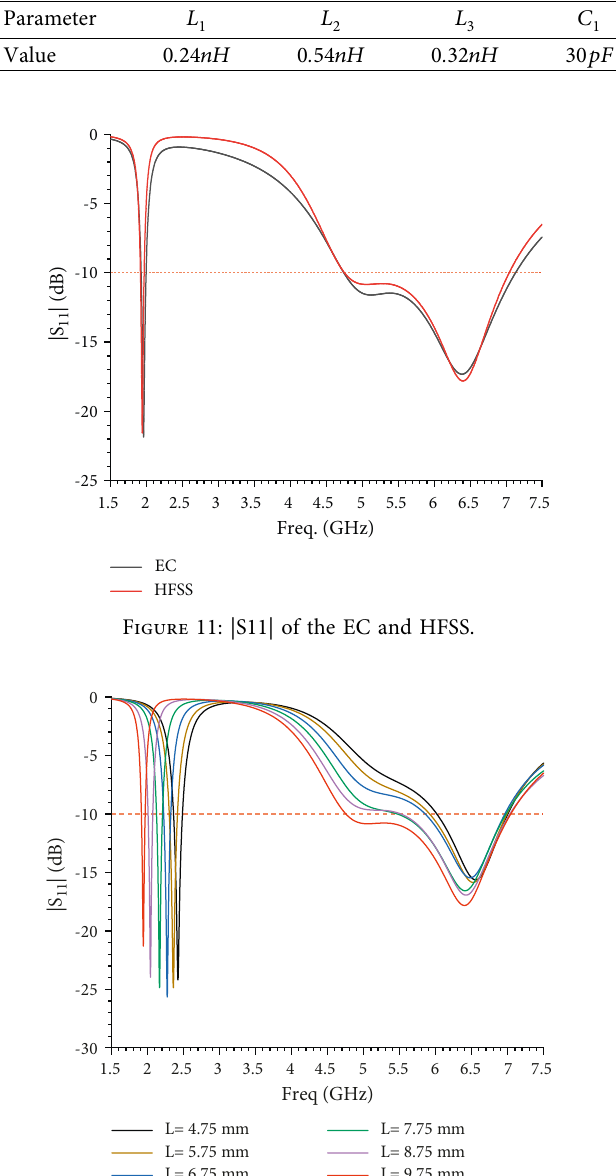
Figure 12: Effect of OBS patch length on resonance response.